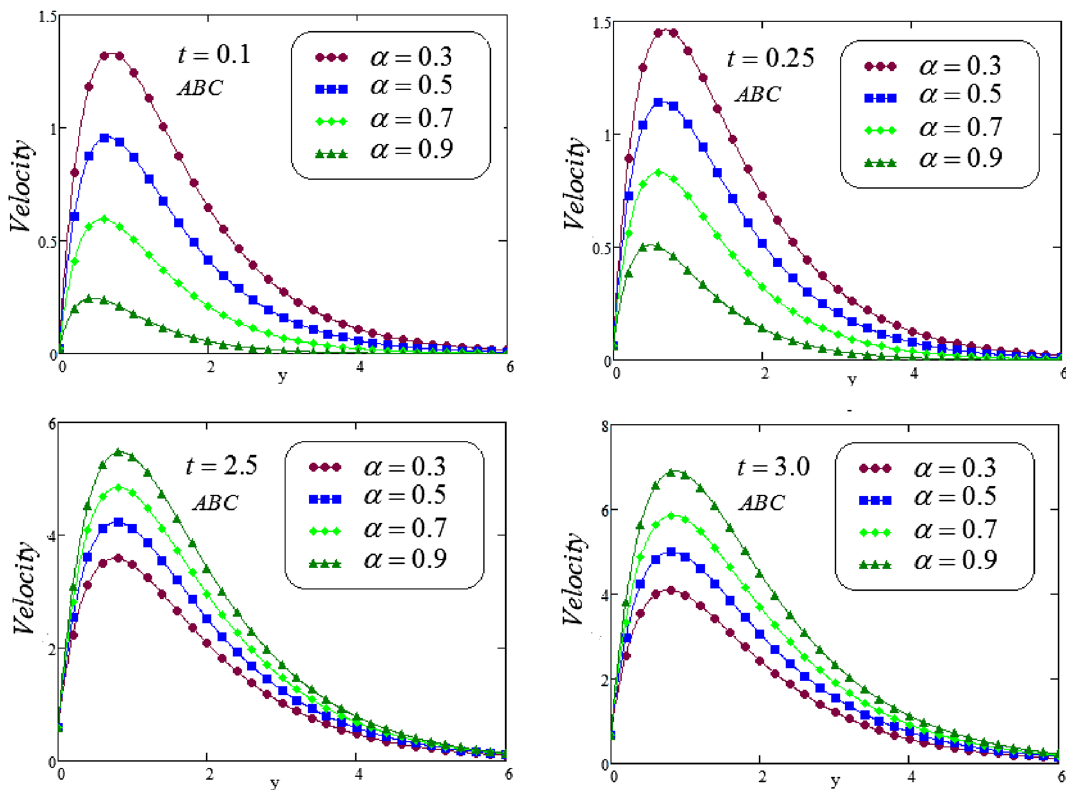
Figure 16. Trace of dimensionless velocity for ABC fractional operator for various values of α .